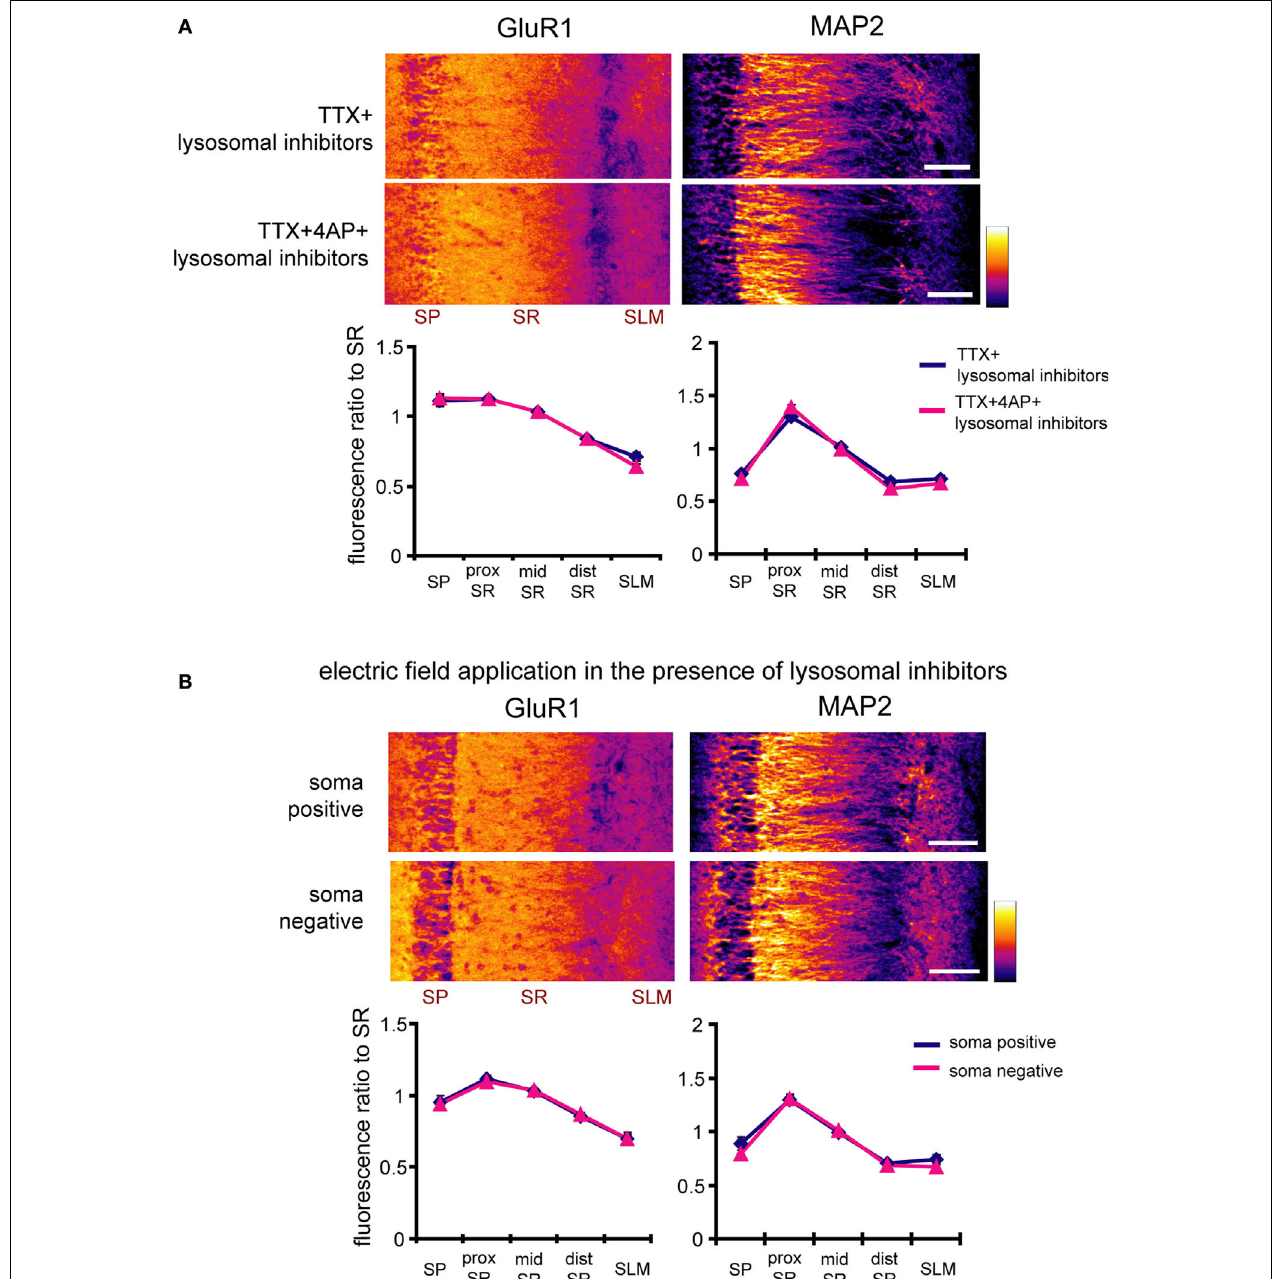
FIGURE 11 | Inhibitors of lysosomal degradation block the enhancement of GluR1 signal ratio in the stratum pyramidale either by 4AP- or external electric fi eld-application. (A) Immunohistochemistry of hippocampal slices was performed after a 12-h treatment with either TTX (2 µM) or TTX + 4AP (5 mM) in the presence of blockers of lysosomal degradation, chloroquine (100 µM) and leupeptin (100 µg/ml). The fl uorescent signal was normalized to the mean signal in stratum radiatum. Inhibitors of lysosomal degradation blocked the GluR1 channels along this gradient may exceed the capacity of molecular diffusion. An electric fi eld-mediated mechanism has the potential advantage to effect an enduring and long-range infl uence along the